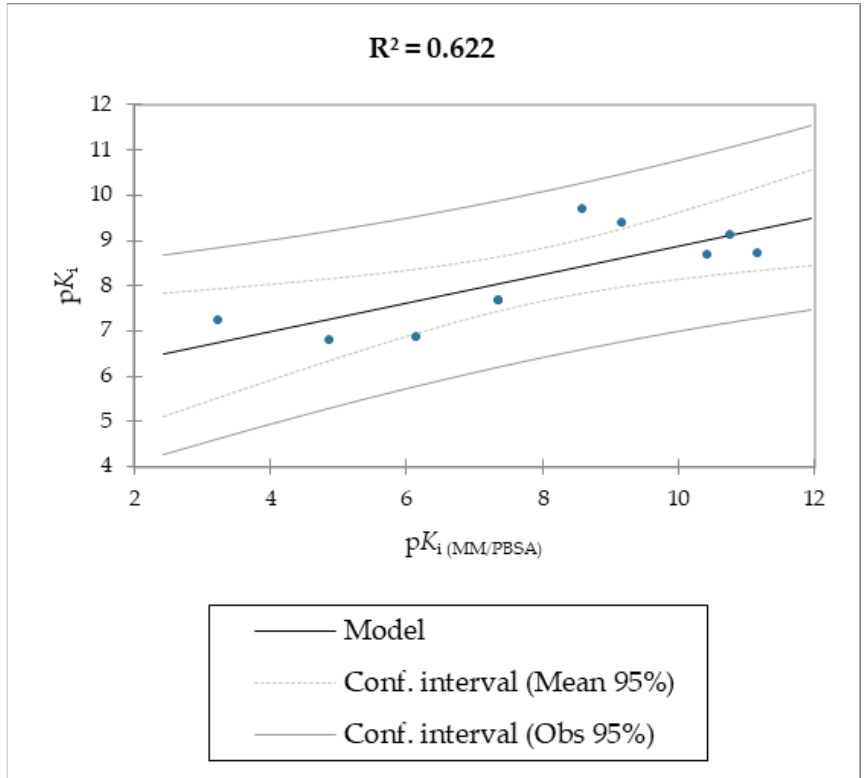
Figure 5. Calculated p K i with MM/PBSA method vs. experimental p K i of molecules 1 – 9.